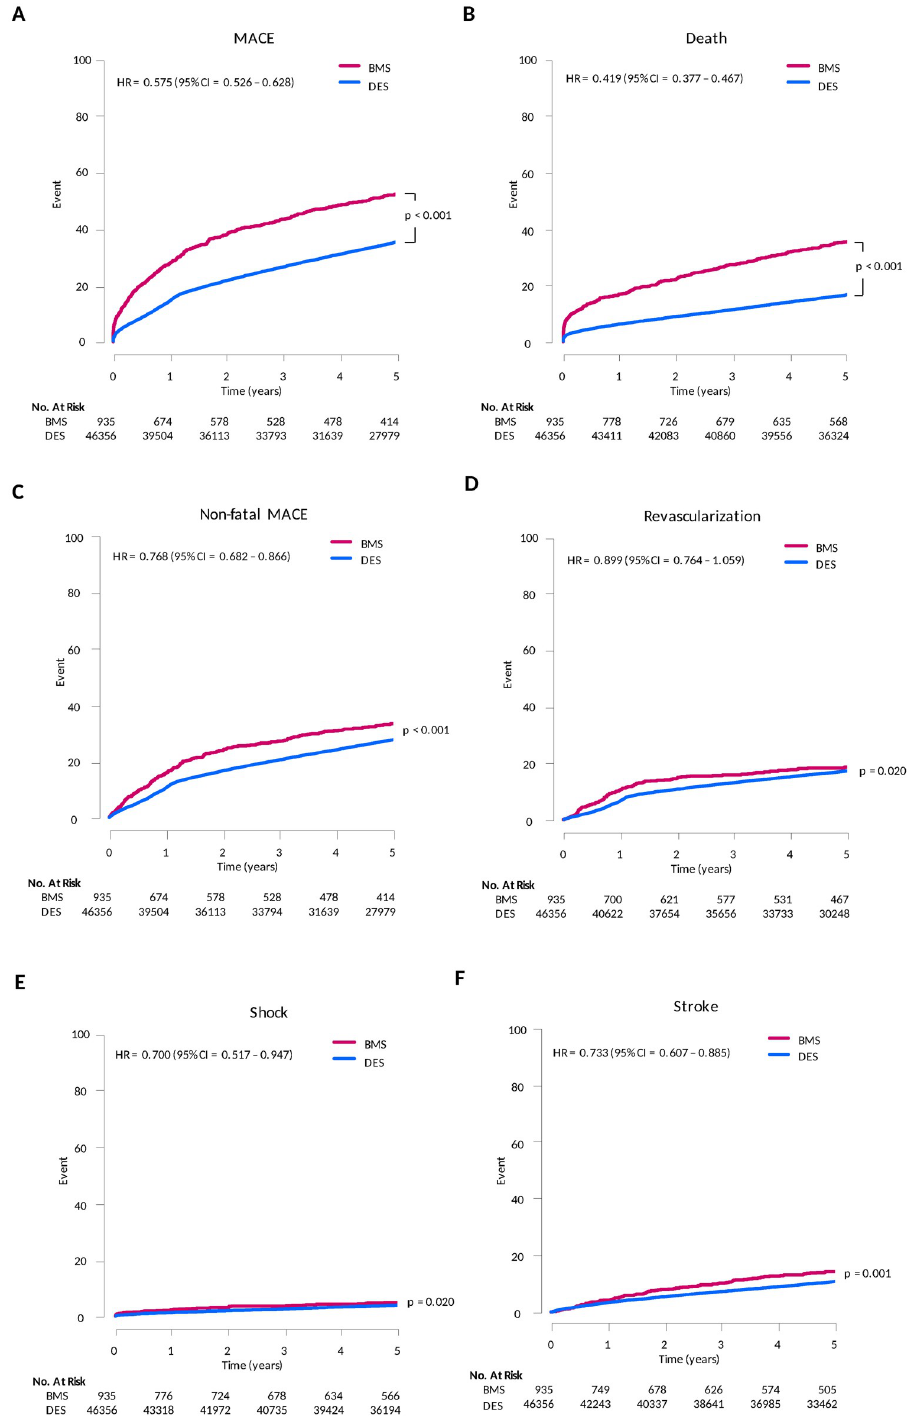
Fig 2. Unadjusted 5-year risk of clinical event. DES showed much lower 5-year cumulative risk of MACE, all-cause death, and non-fatal MACE. However, the risk of revascularization was not different between two groups.